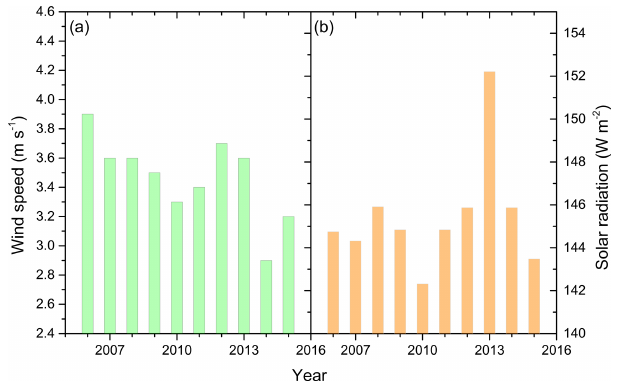
Figure 4. The annual variation in (a) summer wind speed (ms − 1 ) and (b) total solar radiation (Wm − 2 ) from 2006 to 2015 in Shang- hai. Both wind speed and the solar radiation present weak interan- nual variations but without significant